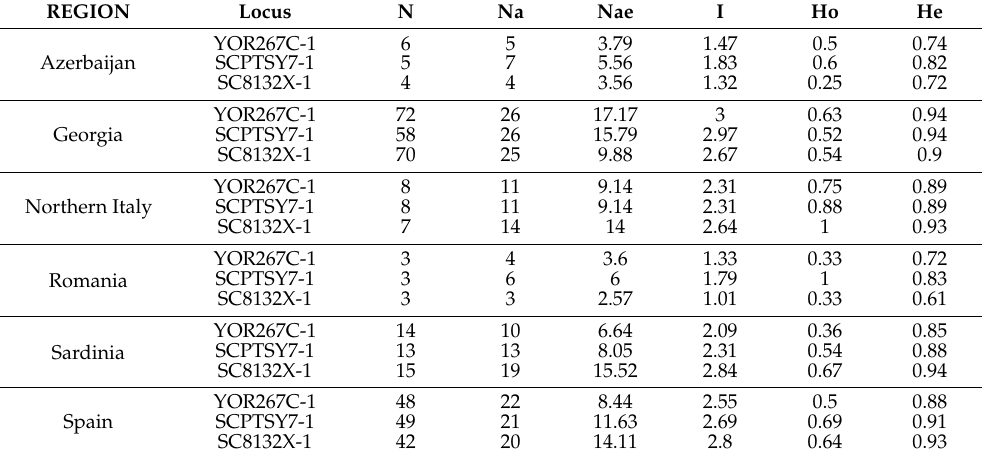
Table 2. Genetic diversity of populations measured by values related to allelic richness (N) and het- erozygosity indices: number of alleles (Na), number of effective alleles (Nae), observed heterozygosity (Ho), expected heterozygosity (He), and Shannon’s information index (I). REGION Locus